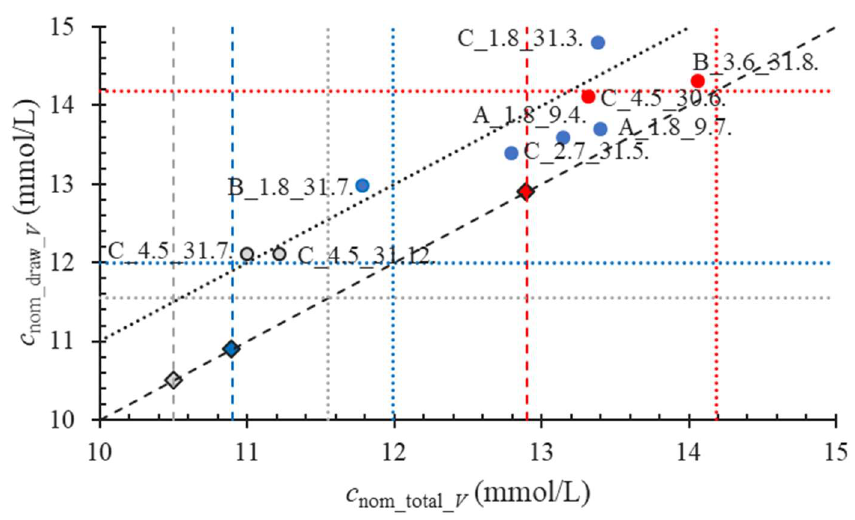
Figure 6. Relation between c _V_total_nom and the c nom_draw_ V . The grey, blue, and red dots pertain to the tubes with 105, 109, and 129 mmol/L nominal anticoagulant concentrations, respectively. The diamonds in the same colours and the vertical dashed lines represent the corresponding accurate con- centrations. The grey, blue, and red dotted vertical lines are the 10% upper limits of the anticoagulant concentrations. The dashed diagonal line is the line with a slope of